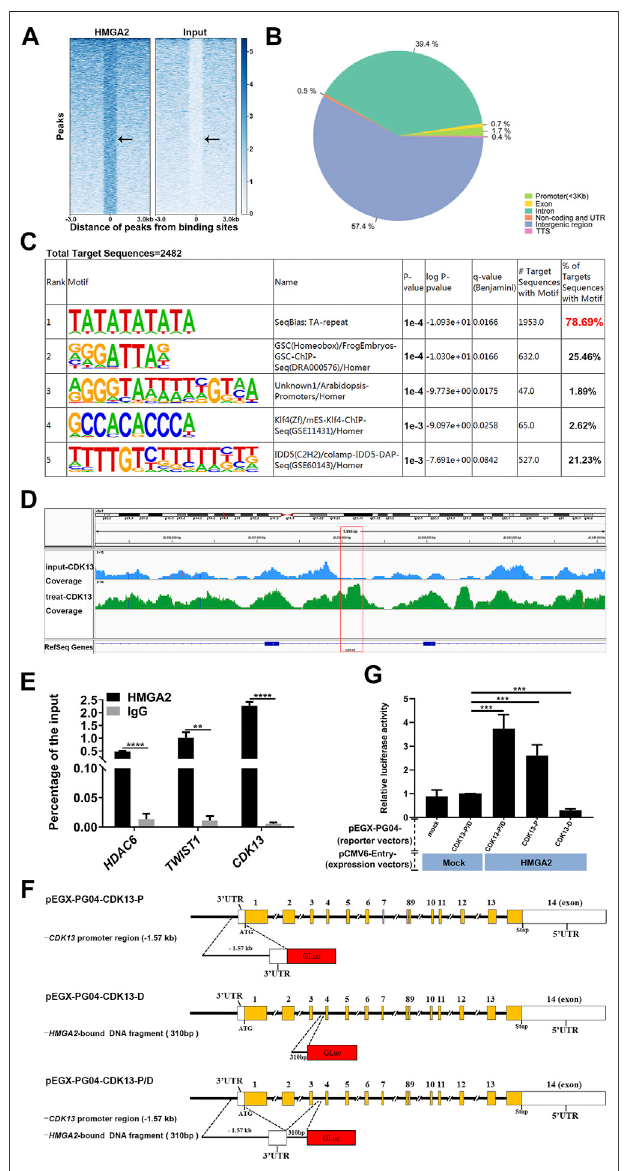
FIGURE 4 | DNA fragment immune-precipitated by HMGA2, that is, the 310bp fragmentonintron3ofthe CDK13 gene;pEGX-PG04-CDK13-P/D (thebottom line): promoterregion of CDK13 plustheDNAfragmentimmune-precipitated by HMGA2. (G) Relative luciferase activity of the reporter vectors with or without HMGA2. HMGA2 -KOMKN-45,inwhichendogenousHMGA2doesnotexpress, was transfected with the HMGA2 expression vector together with luciferase vectors in the following order: pEZX-PG04-Mock vs pCMV6-Entry-Mock; pEZX- PG04-CDK13-P/D vs pCMV6-Entry-Mock; pEZX-PG04-CDK13-P/D vs pCMV6-Entry-HMGA2; pEZX-PG04-CDK13-P vs pCMV6-Entry-HMGA2; and pEZX-PG04-CDK13-D vs pCMV6-Entry-HMGA2. Luciferase activities were normalized to SEAP levels, and the value of the pEZX-PG04-Mock vs pCMV6- Entry-Mock group was set as 1. ** p < 0.01, *** p < 0.001, **** p < 0.0001, Student ’ s t-test. Error bars: